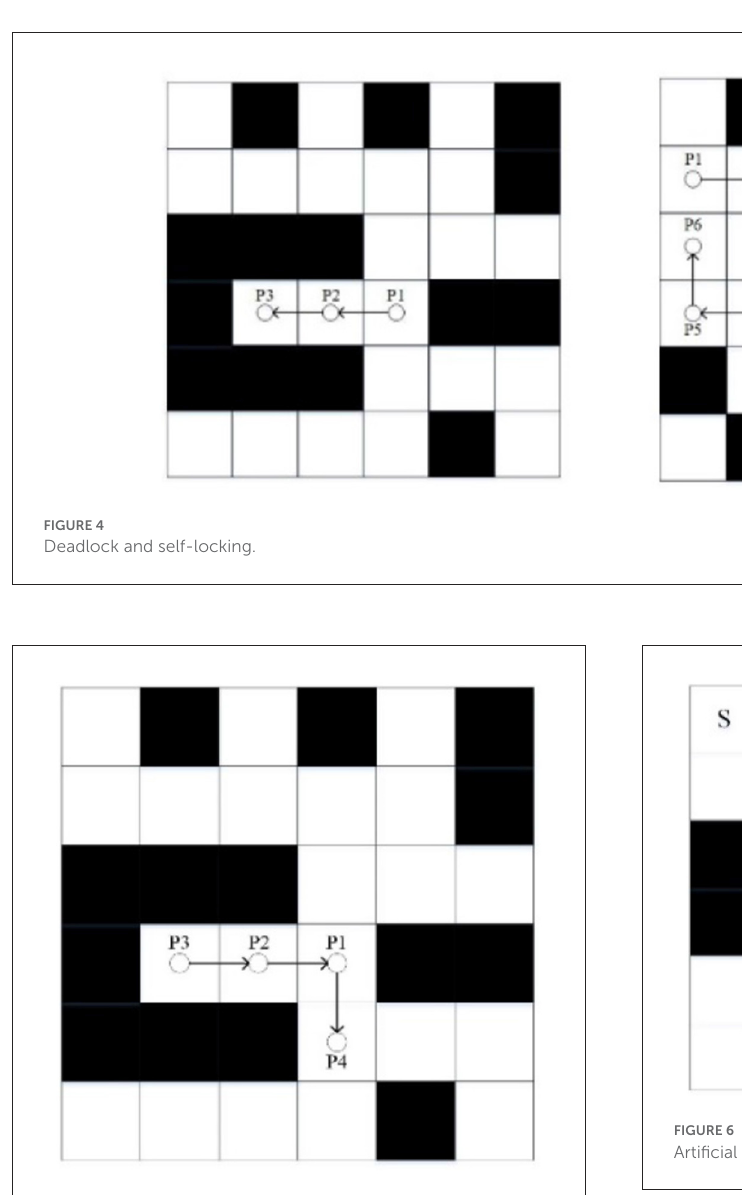
FIGURE5 Fallback strategy.